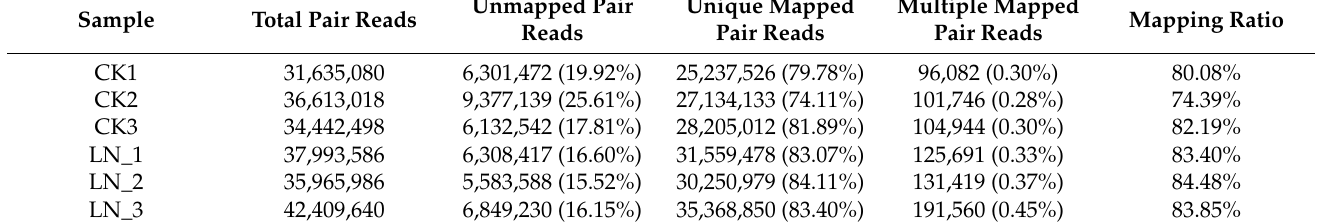
Table 6. Statistical table of comparisons with the reference genome after filtering rRNA.